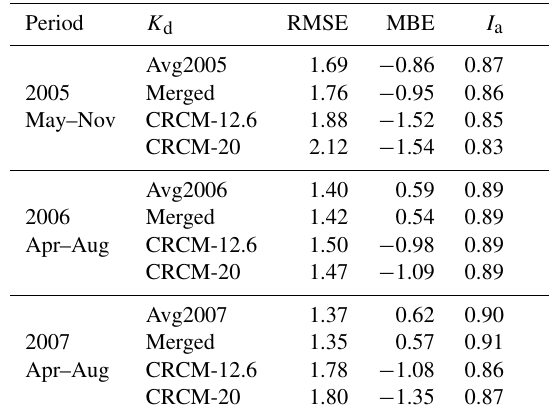
Table 3. Simulated LSWT compared to in situ observations (2005– 2007). Period corresponds to the time of year when LSWT and K d values were